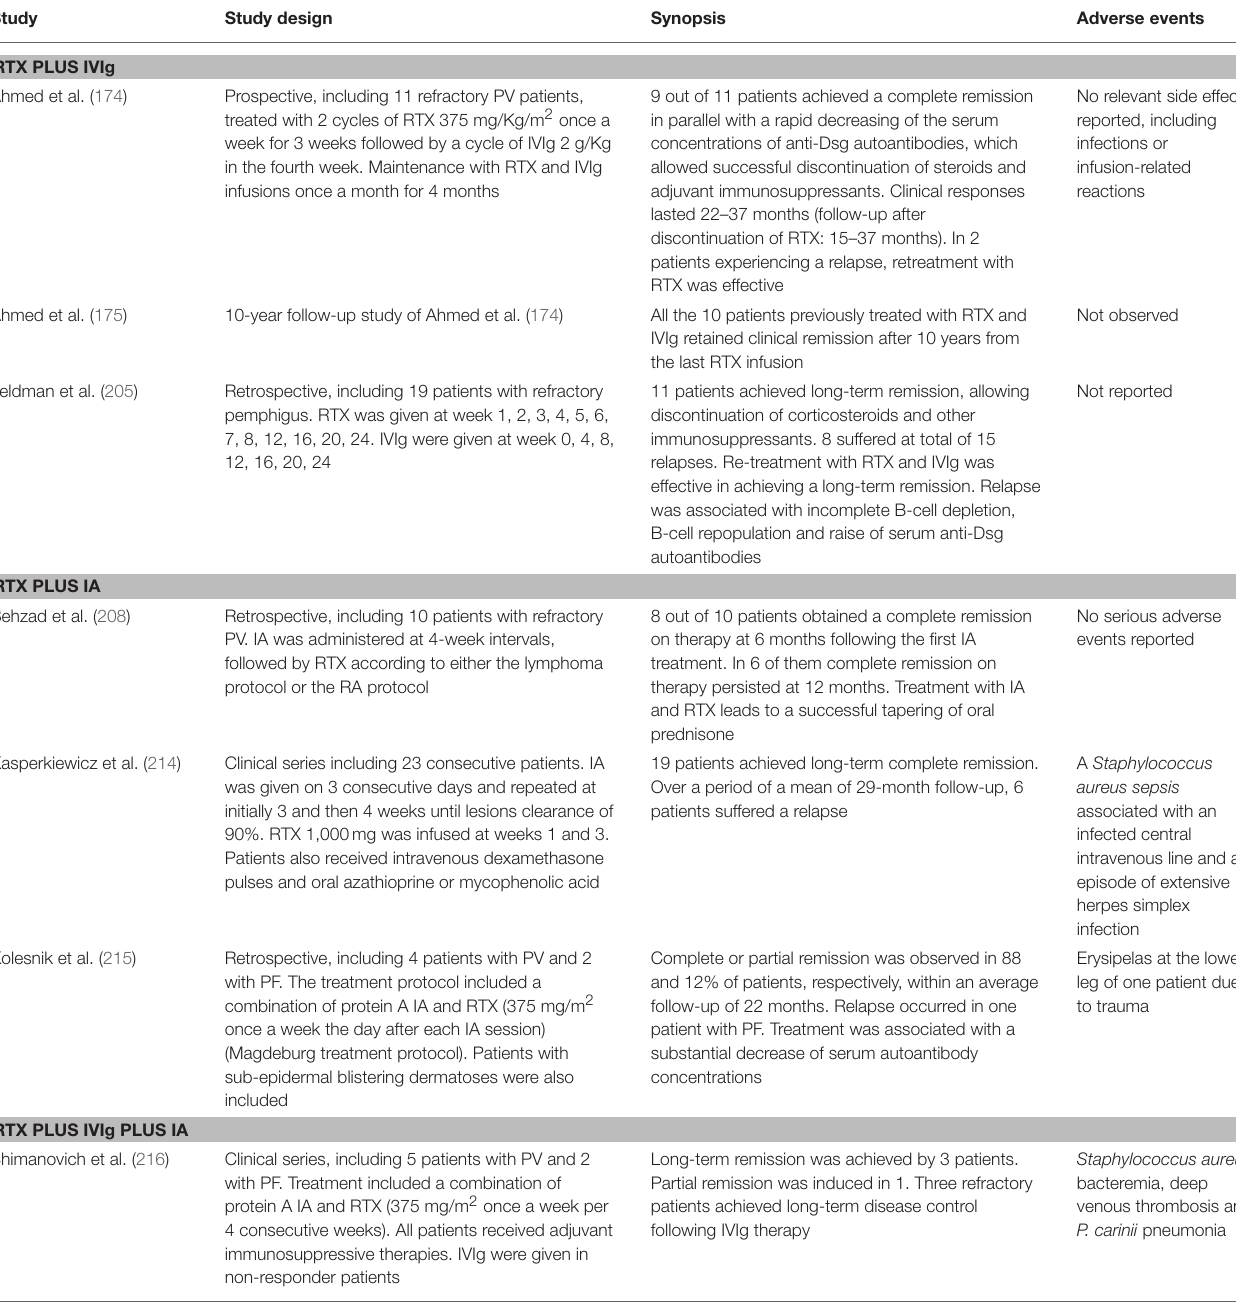
TABLE 2 | Combination therapy of rituximab with intravenous immunoglobulins (IVIg) or immunoadsorption